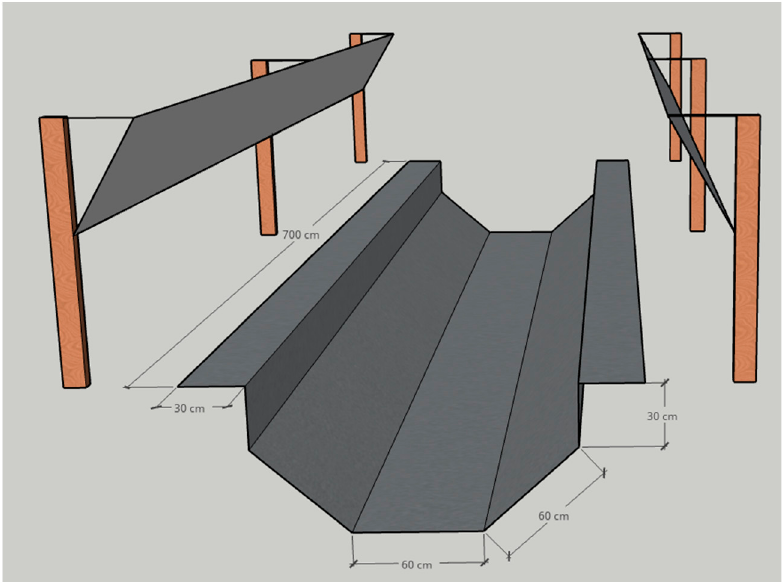
Figure 2. Dimensions of the disinfection canal.